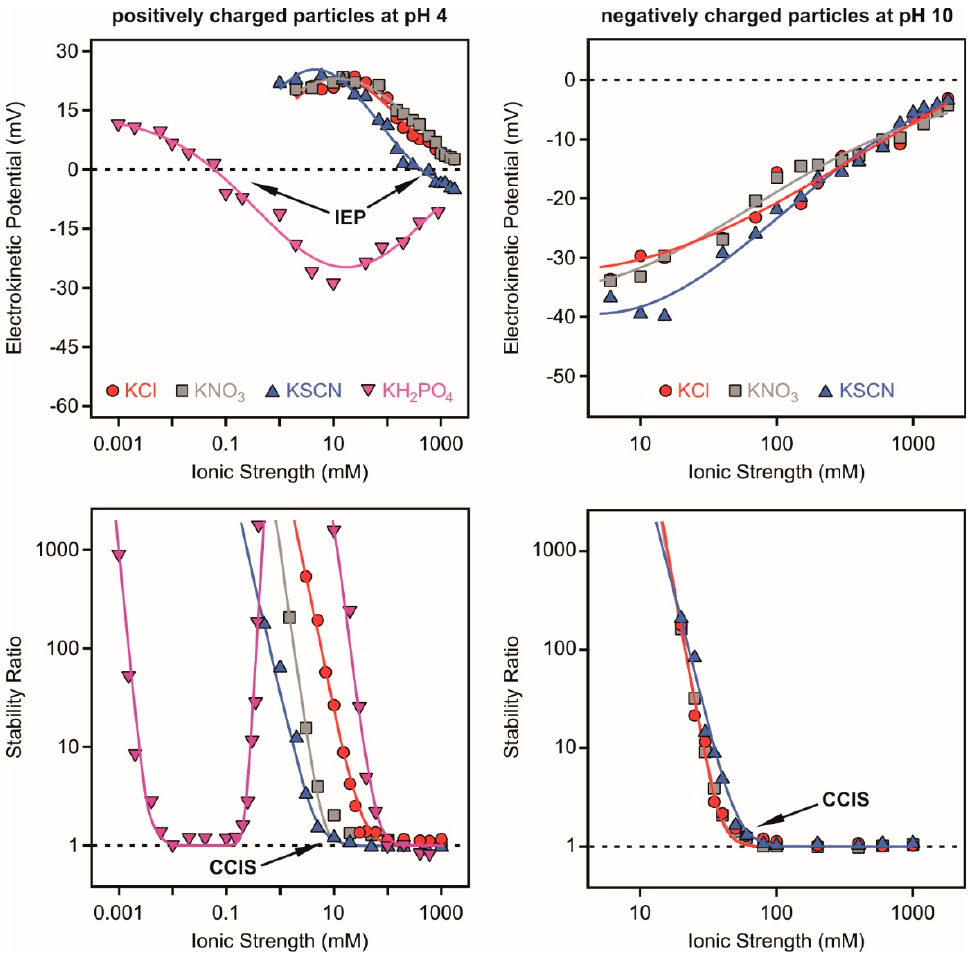
Figure 3. Electrokinetic potentials ( top row ) and stability ratios ( bottom row ) of titania nanosheets as a function of the ionic strength set by different monovalent electrolytes below the PZC at pH 4 ( left column ) and above the PZC at pH 10 ( right column ), where the nanosheets are positively or negatively charged, respectively. The particle concentration was 1 mg/L. Reprinted with permission from Reference [59]. Copyright (2017) American Chemical Society.